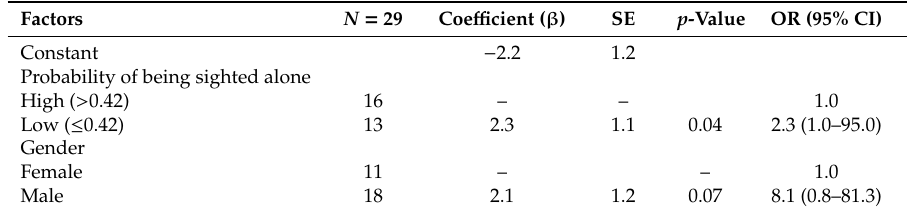
Table 7. Final multivariable logistic regression model with regression coe ffi cient values for predictors yielding significant p -values for dichotomised home-range area for free-roaming dogs in rural Shirsuphal,